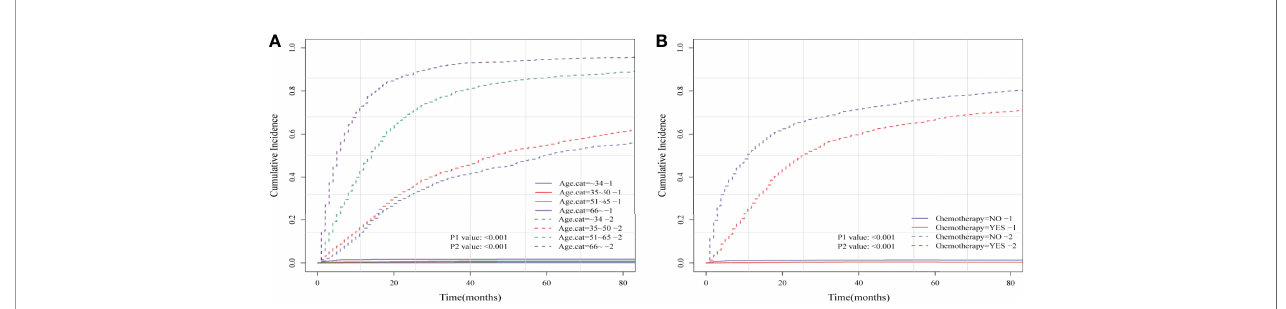
FIGURE 3 | Cumulative incidence plots based on the competing risk regression model of anaplastic astrocytoma patients strati fi ed according to (A) age at diagnosis and (B) chemotherapy status.